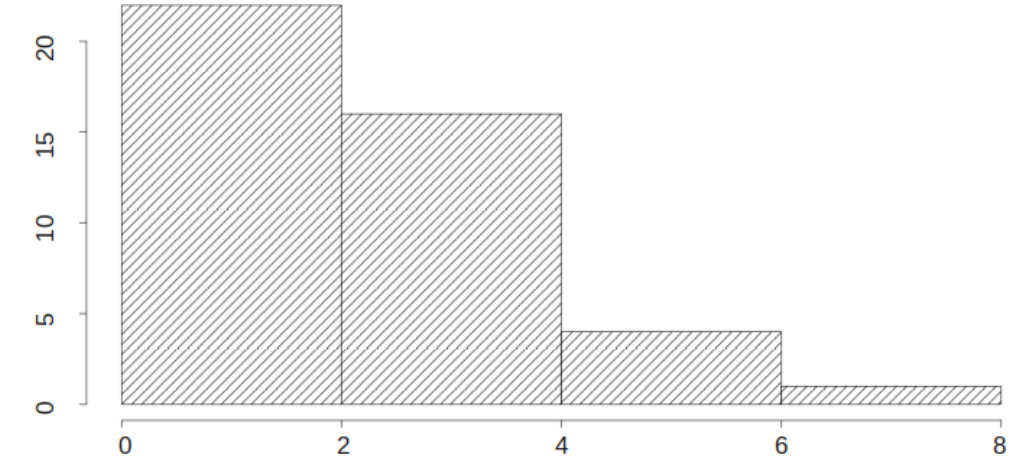
Figure 7. Histogram of the number of months passed after the end of the